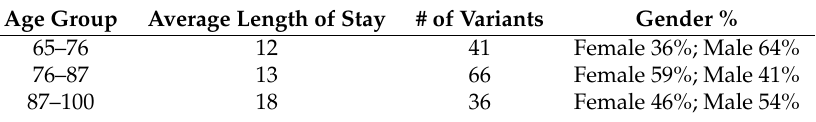
Figure 8. Length of stay of patients between 87 and 100 years of age. Table 3. A comparative summary of different pneumonia groups